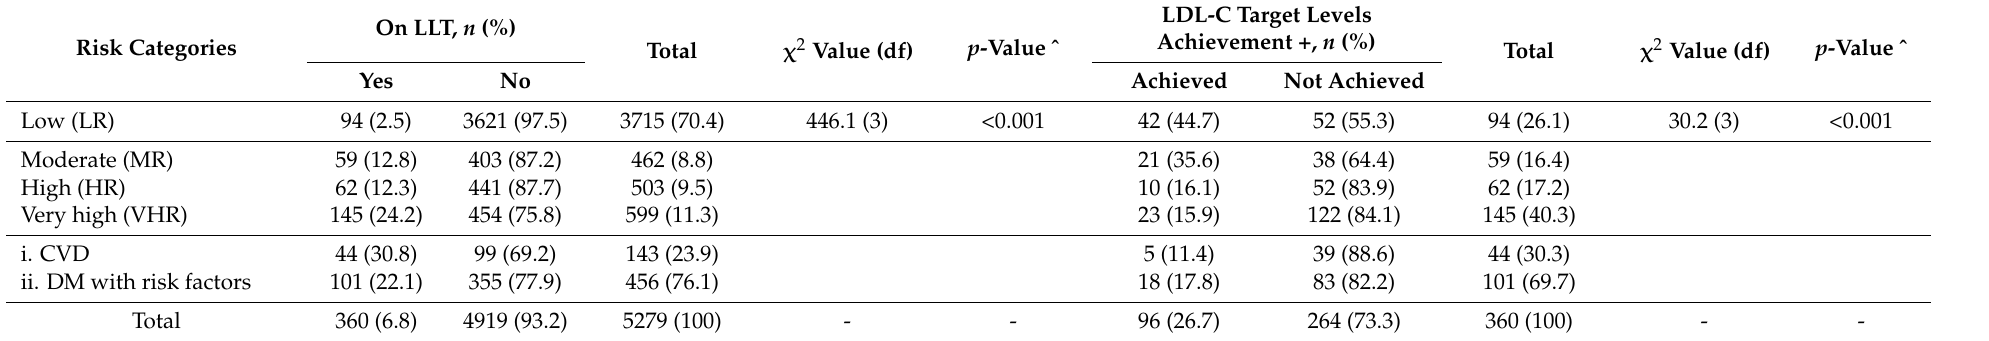
Table 3. Proportions of LLT use and the achievements of LDL-C targets according to risk